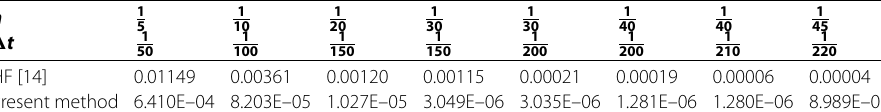
Table 1 The maximum error for Example 1 at different values of h , (cid:2) t for γ = 1.5 and t = 0.2 h 1 5